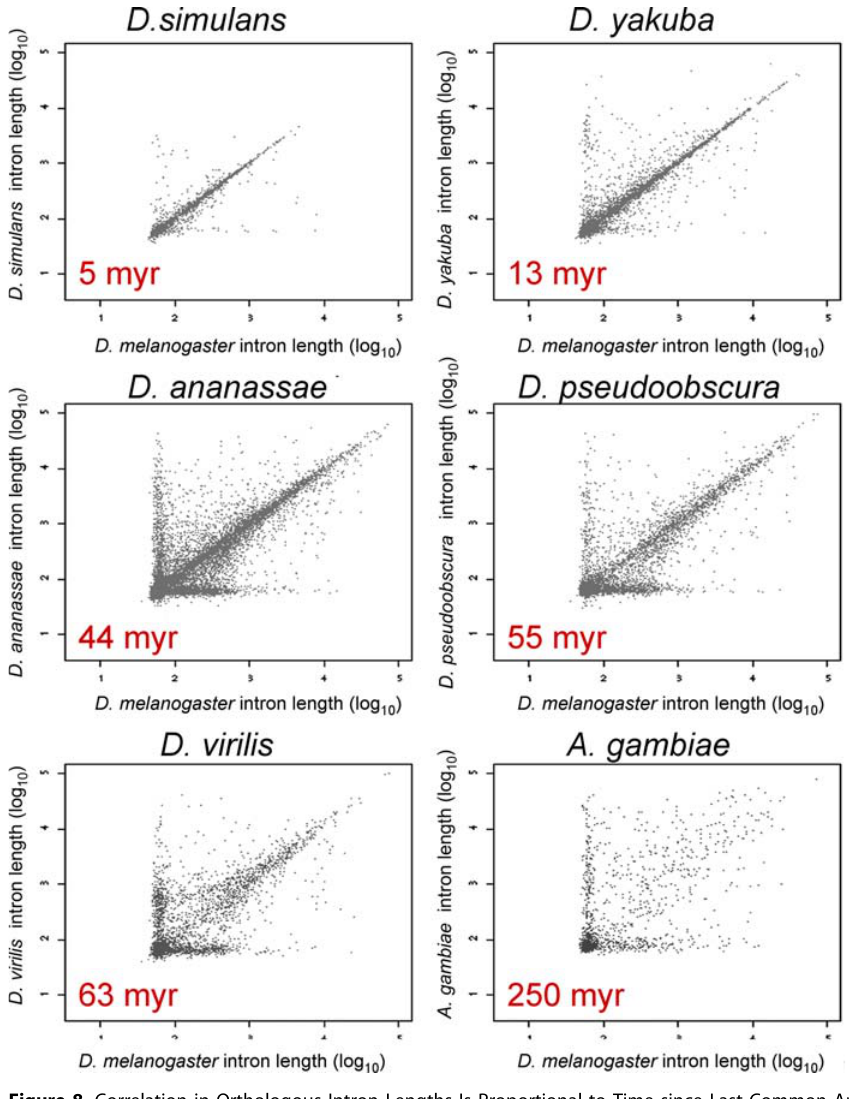
Figure 8. Correlation in Orthologous Intron Lengths Is Proportional to Time since Last Common Ancestor From left to right, and top to bottom: Annotated D. melanogaster lengths ( x -axis) versus inferred orthologous intron lengths ( y -axis) for D. simulans (strain 6), D. yakuba, D. ananassae, D. pseudoobscura, and D. virilis . Bottom right-hand panel: Annotated D. melanogaster lengths ( x -axis) versus inferred A. gambiae intron lengths ( y -axis). Approximate time since last common ancestor is shown in red in the lower left-hand corner in each panel; these are approximate estimates based upon protein data [30]. Spearman correlation coefficients: 0.886, 0.863, 0.670, 0.637, 0.550, and 0.410 for D. simulans, D. yakuba, D. ananassae, D. pseudoobscura, D. virilis, and A. gambiae distributions, respectively. p , 0.001 for each correlation coefficient. See Materials and Methods for analysis